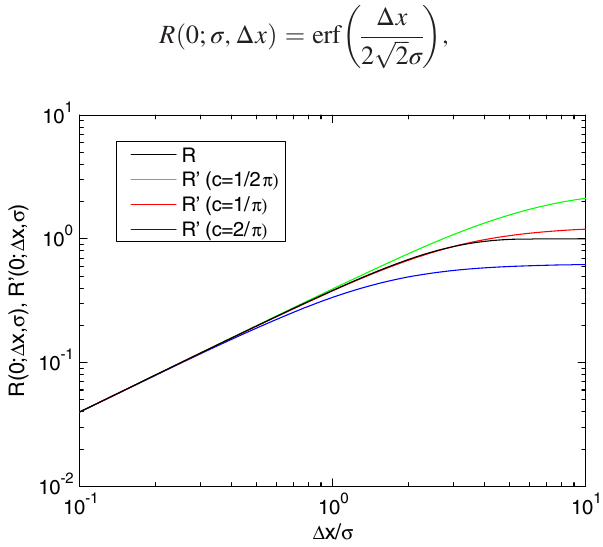
FIG. 10. Functions R and R 0 plotted as a function of Δ x= σ . Three different values of c ¼ 1 = 2 π , 1 = π , and 2 = π are assumed for R 0